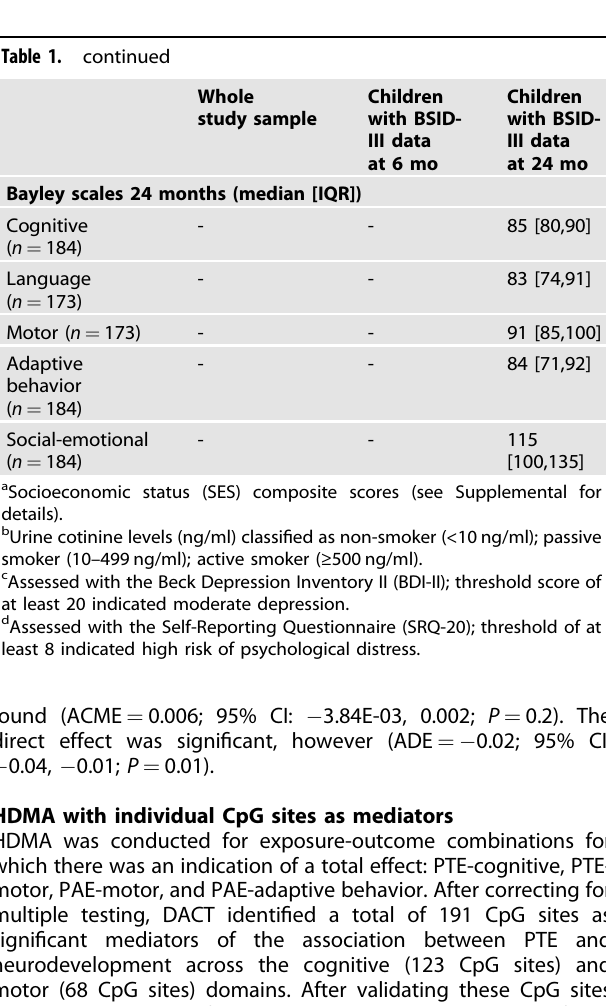
association between PAE and neurodevelopment across the motor (100 CpG sites) and adaptive behavior (93 CpG sites) domains. After conducting CMA, this resulted in 16 CpG sites and 1 CpG site with a signi fi cant mediating effect between PAE and the motor and adaptive behavior domains, respectively (Table 3). The second HDMA method we tested, HIMA, did not identify any CpG sites as potential mediators of the association between either PTE and PAE and neurodevelopment at 6 months of age after correction for multiple testing. None of the CpG sites identi fi ed as signi fi cant mediators for neurodevelopment at 6 months mediated the association between PTE or PAE and neurodevelopment at 24 months (Tables S4, S5). Secondary analyses After correction for multiple testing (FDR <0.05), we did not identify any GO terms or KEGG pathways with an overrepresenta- tion of genes containing signi fi cantly, differentially methylated CpGs that would indicate an enriched biological pathway. The top GO terms and KEGG pathways for each E-O model are included in the supplement (Table S7a, b).